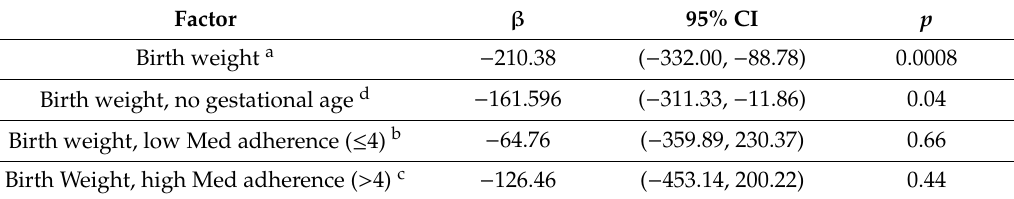
Table 3. Regression coe ffi cients and 95% confidence intervals for the association / relationship between, cadmium exposure and weight.